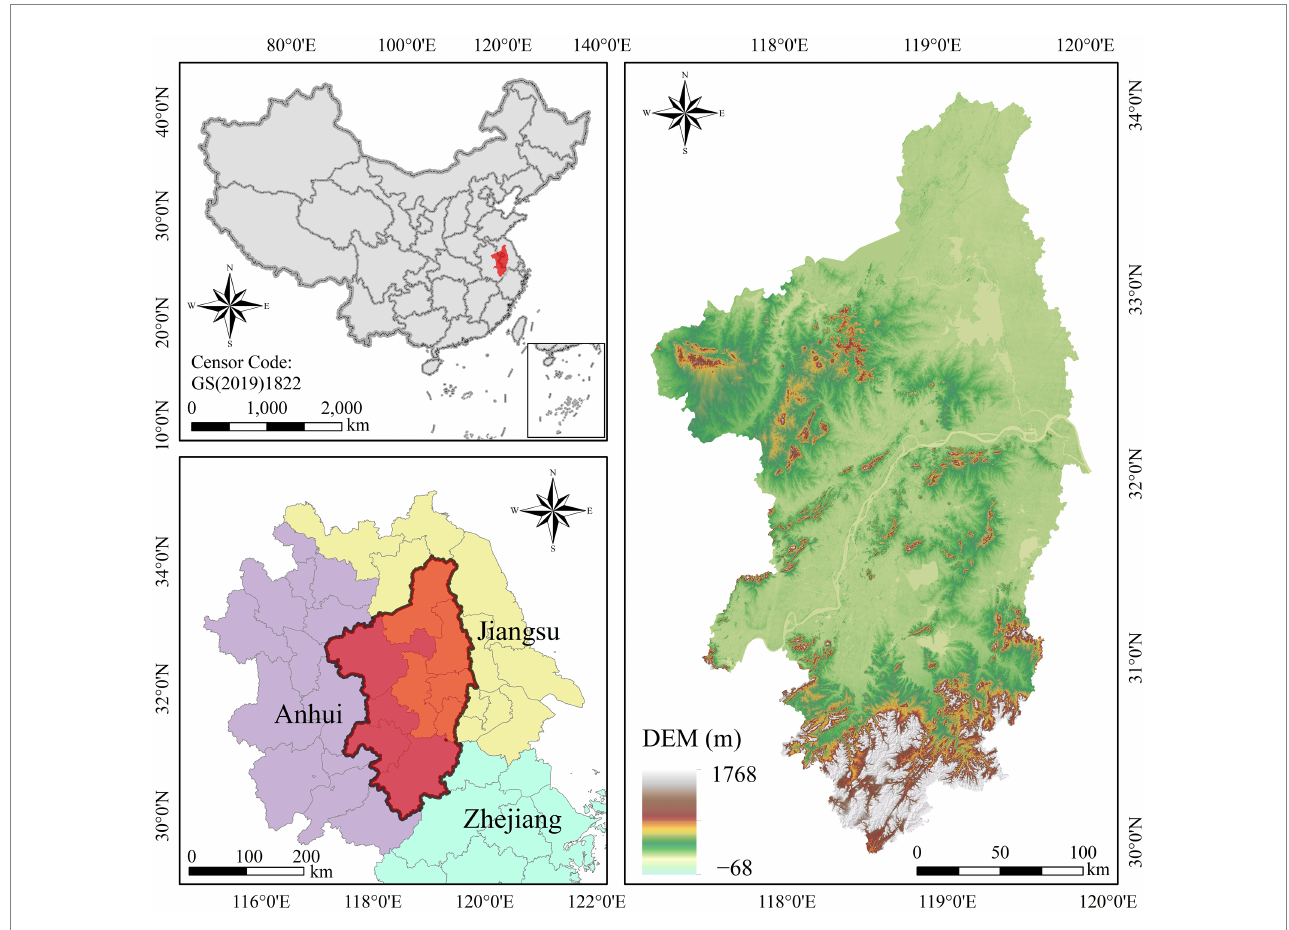
FIGURE 1 Location of Nanjing metropolitan circle with a digital elevation model